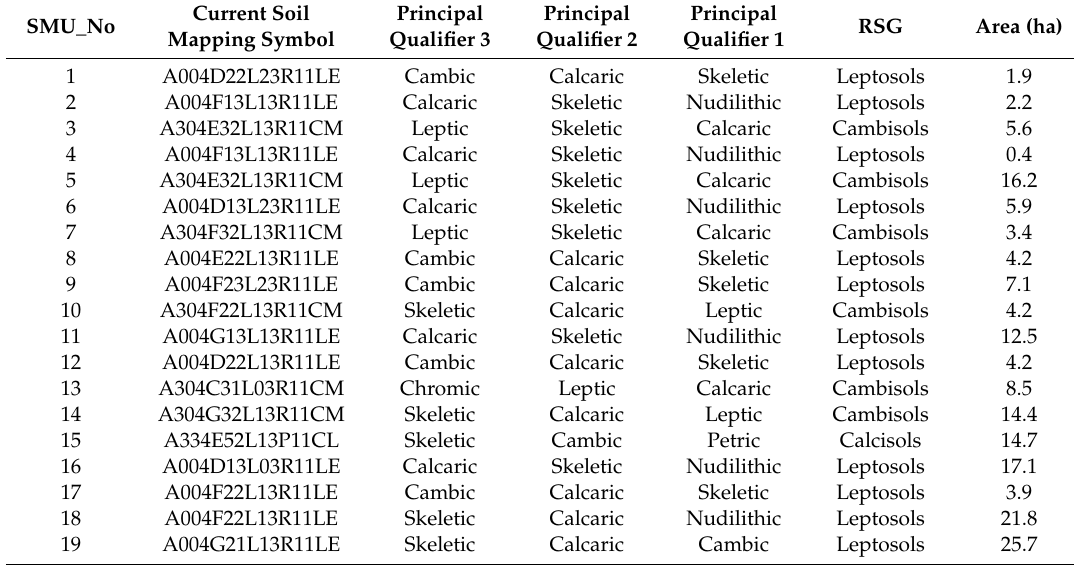
Table A9. SMU numbering, symbolization, occupied area and soil’s taxonomy of the currently applied methodology (2019 mapping